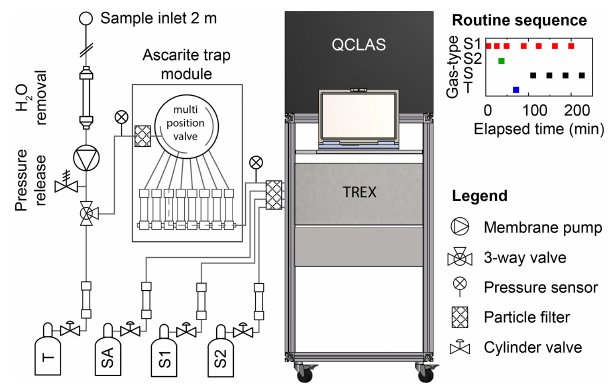
Figure 2. Instrumental setup for semicontinuous analysis of N 2 O isotopes by coupled pre-concentration laser spectroscopy (TREX- QCLAS) (Ibraim et al., 2018), including peripherals for the condi- tioning of the sample gas. Consecutive sample gas treatments in- clude dehumidification by permeation drying, adjustment of sam- ple gas pressure with a pressure release valve after the membrane pump, and CO 2 or H 2 O removal using Ascarite or Mg ( ClO 4 ) 2 traps and filtering for particles using a sintered metal filter. An automized multiposition valve enables us to switch between eight different As- carite traps and thus reduces the maintenance effort to one visit per 8d. The indicated gases are target gas (T), synthetic air (SA), stan- dard gas 1 (S1), and standard gas 2 (S2). CO is removed from the analyte gases using a Sofnocat catalyst (type 423, Molecular Prod- ucts LTD). At the top right, a full measurement cycle is given. Let- ters on the y axis correspond to different gas types: standard 1 (S1) and standard 2 (S2) sample (S) and target (T) gases. The x axis gives the elapsed time in minutes. The full measurement cycle lasts approx. 4h, which results in a frequency of approx. one per hour for ambient air